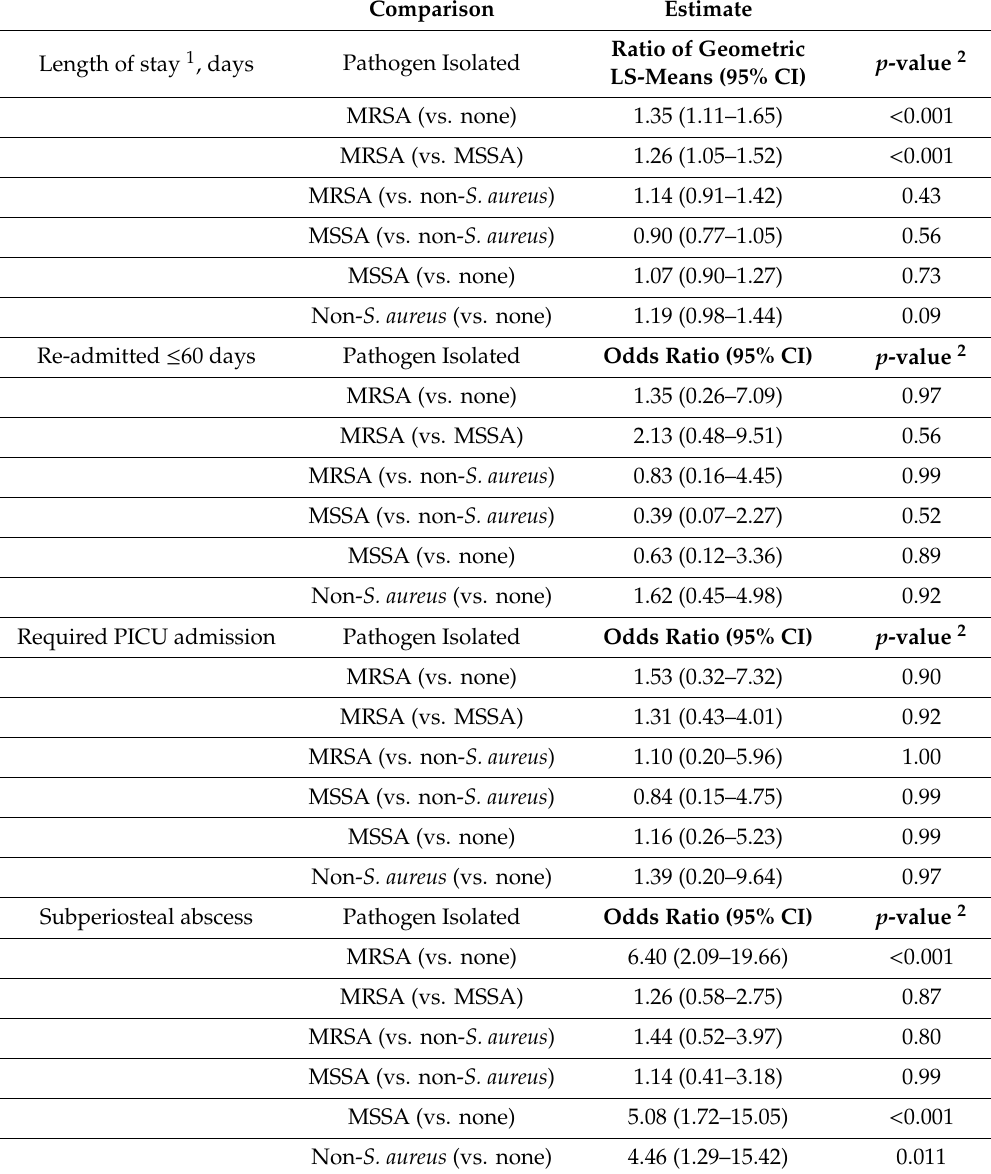
Table 3. Adjusted di ff erences in selected health outcomes by isolated